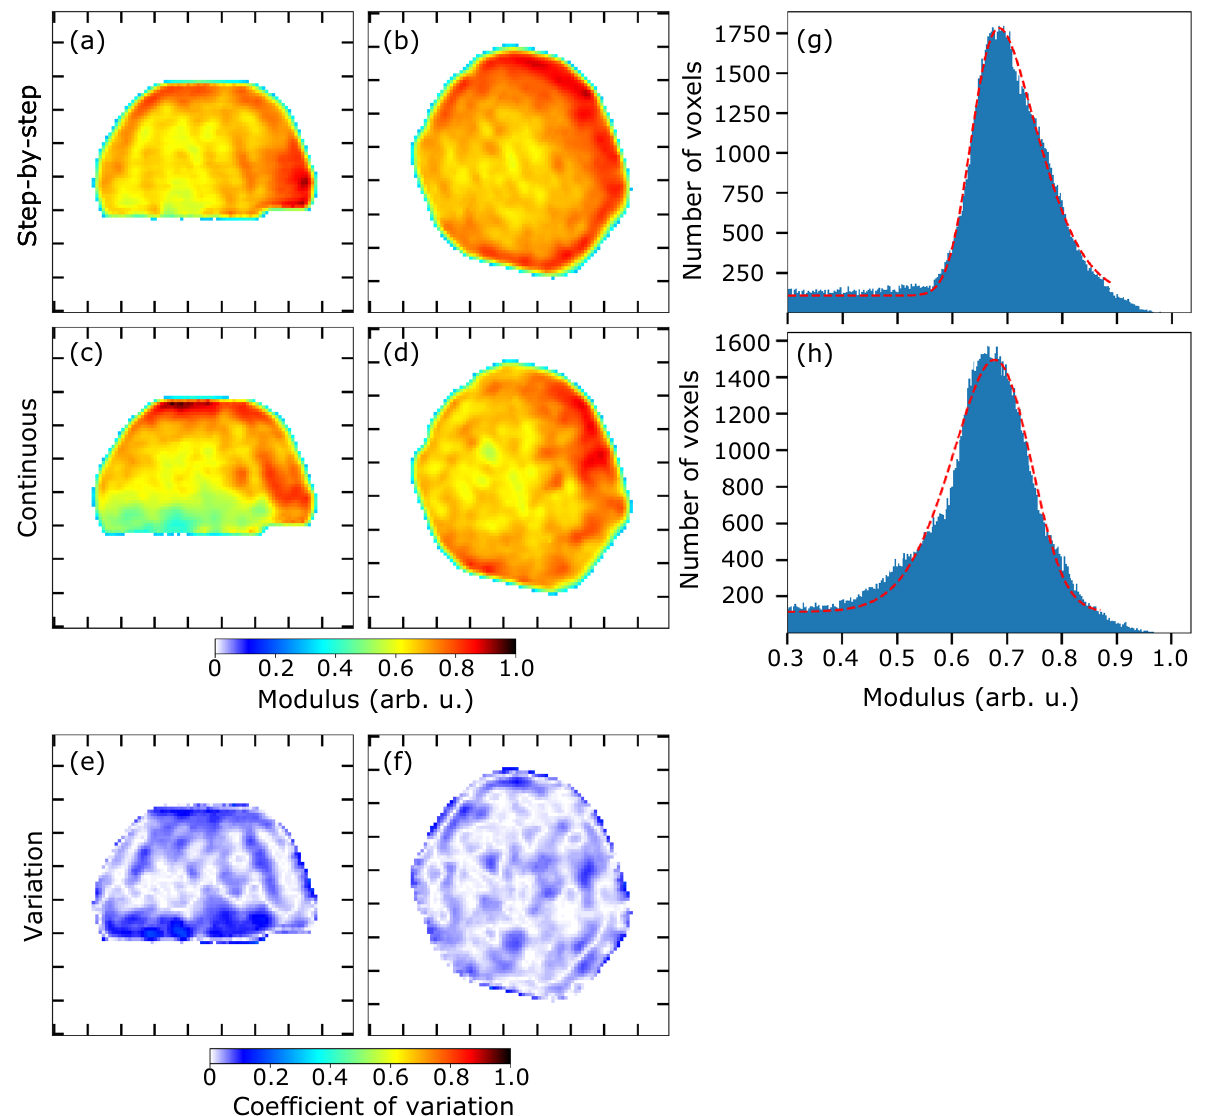
Figure 3. Comparison of retrieved modulus. ( a , b ) Central slice of the reconstructed modulus in yz and xy planes for the step-by-step scan. ( c , d ) Central slice of the reconstructed modulus in yz and xy planes for the continuous scan. ( e , f ) Coefficient of variation of the central slice of the reconstructed modulus in yz and xy planes. Ticks correspond to 100 nm. ( g , h ) Histograms of the reconstructed modulus for the step-by-step and continuous scanning modes with their corresponding fit (red